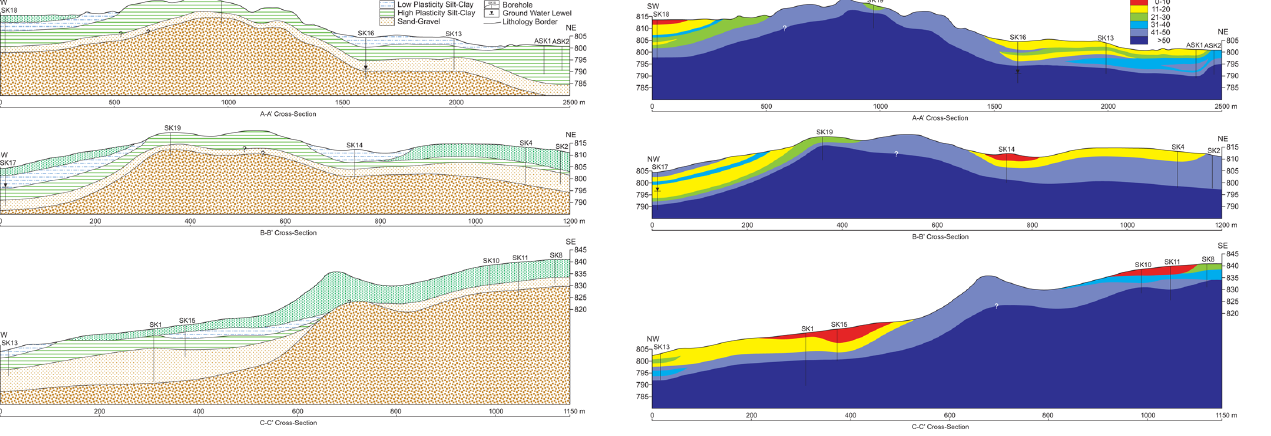
Fig. 9. SPT cross-sections created for the study